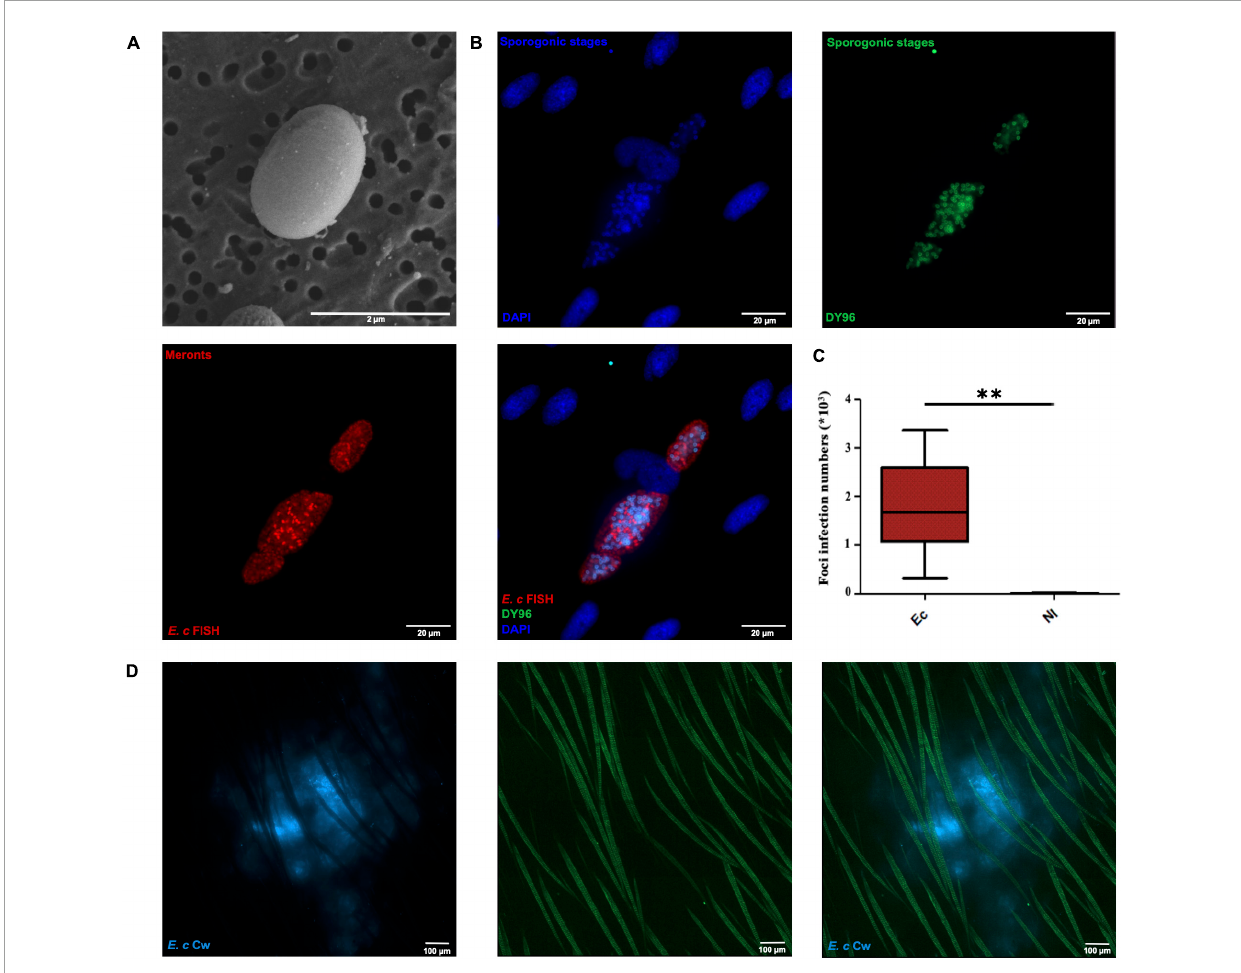
FIGURE1 Properties of calibrated inocula of Encephalitozoon cuniculi Calcofluor White labeled spores. SEM micrograph of a CW-labeled spore (A) . Fluorescence microscopy images of a E. cuniculi infectious foci inside HFF cells after FISH labeling and DY96 counterstaining (B) . E. cuniculi foci infection numbers inside HFF cells 3 days pi. **: Statistically significant difference compared with the control group (PBS) with p < 0.005. Mann-Whitney statistical test. Five independent experiments, n = 15 Ec infected cells and n = 15 non-infected (NI) cells (C) . Reconstituted confocal images of the intradermal injection site showing the maximal projection intensities of the CW signal. Autofluorescent hairs appear in green (D) . Scale bar: 10 µ